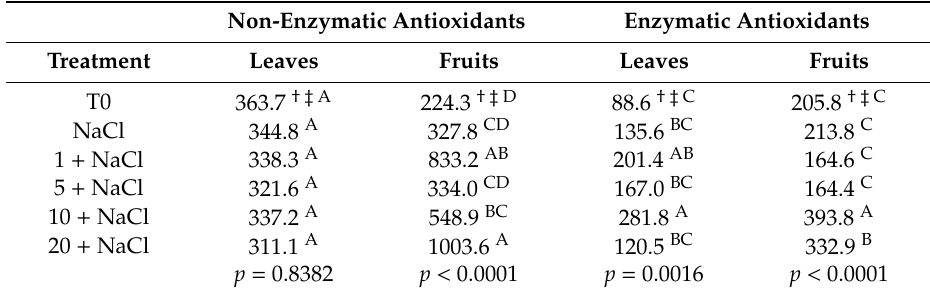
Figure 3. Non-enzymatic antioxidant compounds ( a ) Vitamin C, ( b ) GSH, ( c ) Flavonoids, ( d ) Phenols) in tomato leaves under NaCl stress and an application of Se NPs. T0: Control. NaCl: NaCl-only treatment. 1, 5, 10, and 20 + NaCl: Represent the amount of Se NPs applied (mg L − 1 ) plus 50 mM of NaCl. FW: Fresh weight. DW: Dry weight. Di ff erent letters per bar indicate significant di ff erences according to Fisher’s Least Significant Di ff erence test ( p < 0.05). Table 2. MANOVAs of di ff erent variables of leaves and fruits of tomato plants under NaCl stress and an application of Se